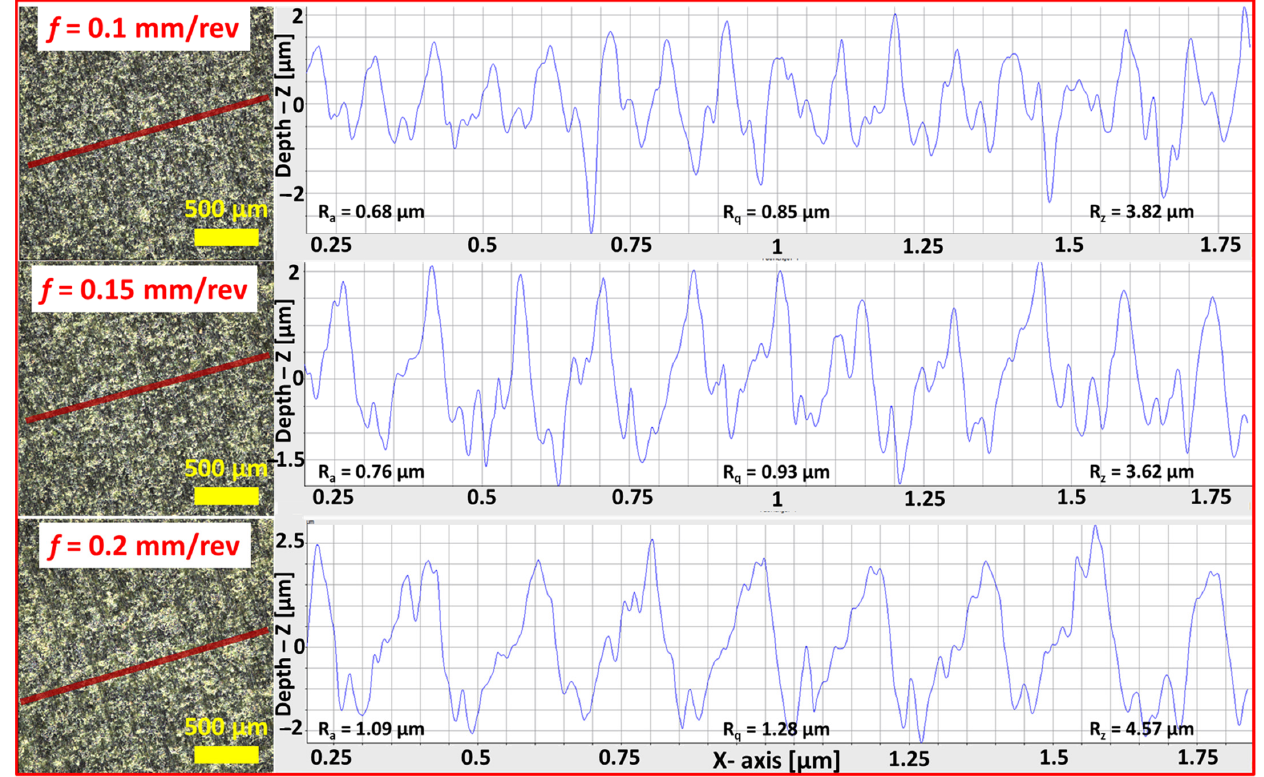
Figure 13. The profilograms measuring the variation in the edge roughness parameters for the top side by changing the feed velocities.